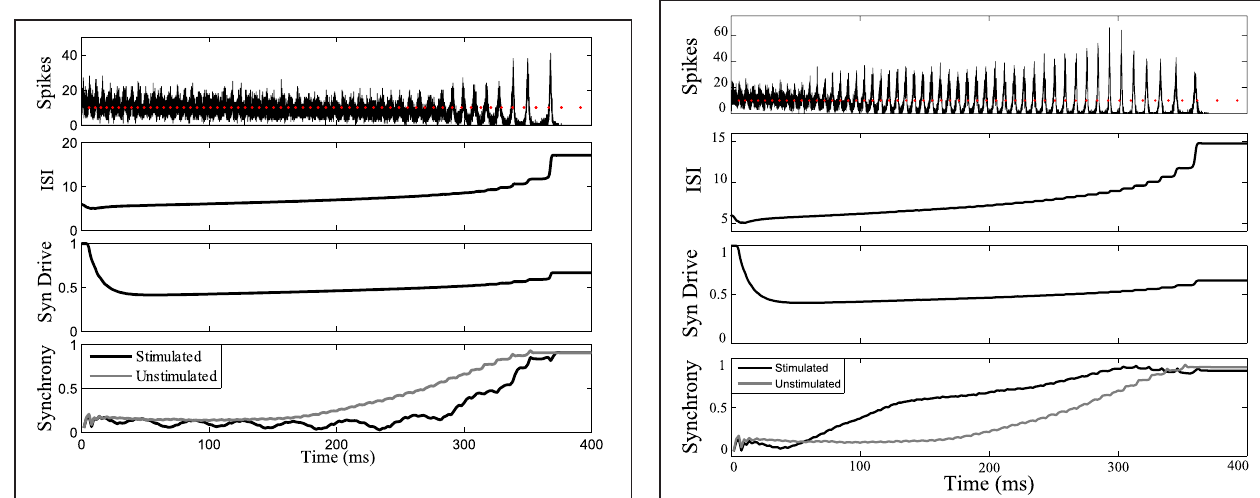
FIGURE 7 | Tonic phase prolonged. Stimulating at a desynchronizing frequency ratio of 1:1.14 where the stimulus is firing slightly slower than the measured frequency of one chosen cell. The tonic phase of low synchrony is prolonged when stimulating compared to the unstimulated model. Graphs labeled the same as Figure 3 .